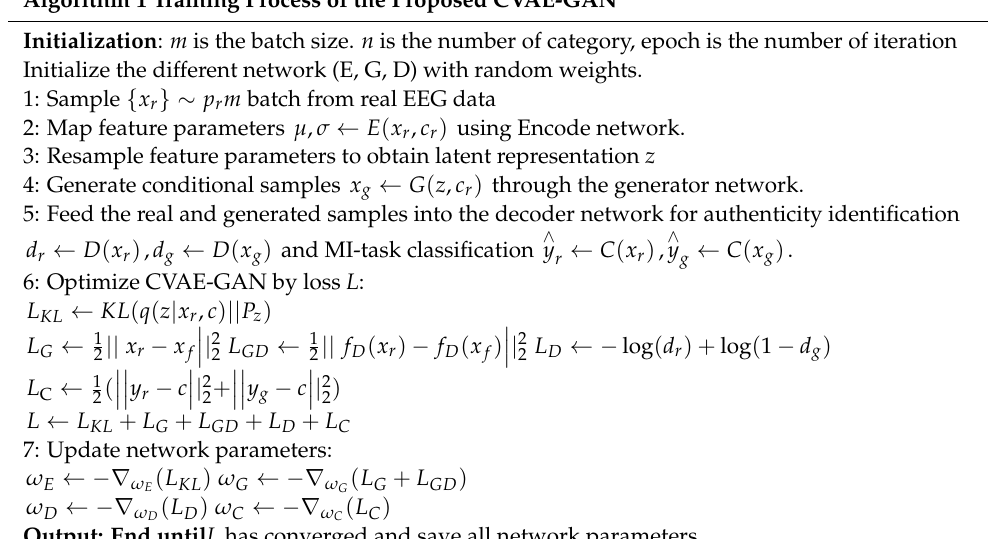
Algorithm 1 Training Process of the Proposed